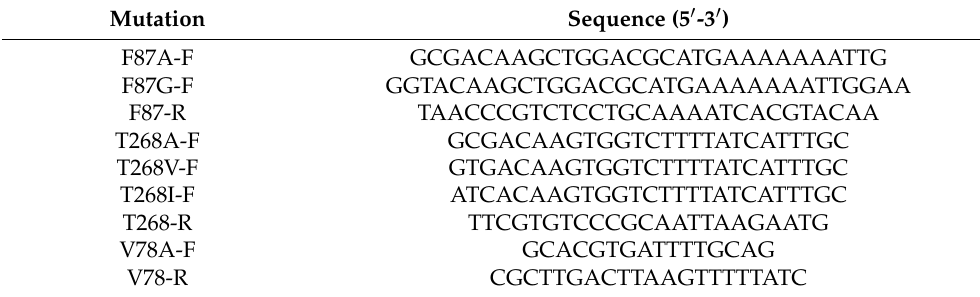
Table 3. Primers used in